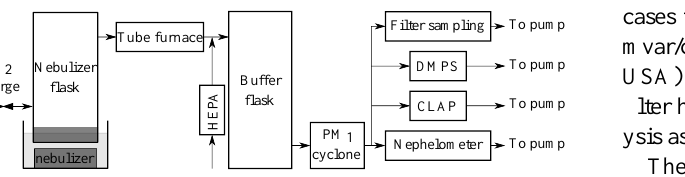
Figure 1. Experimental setup for the tar ball generation and mea-